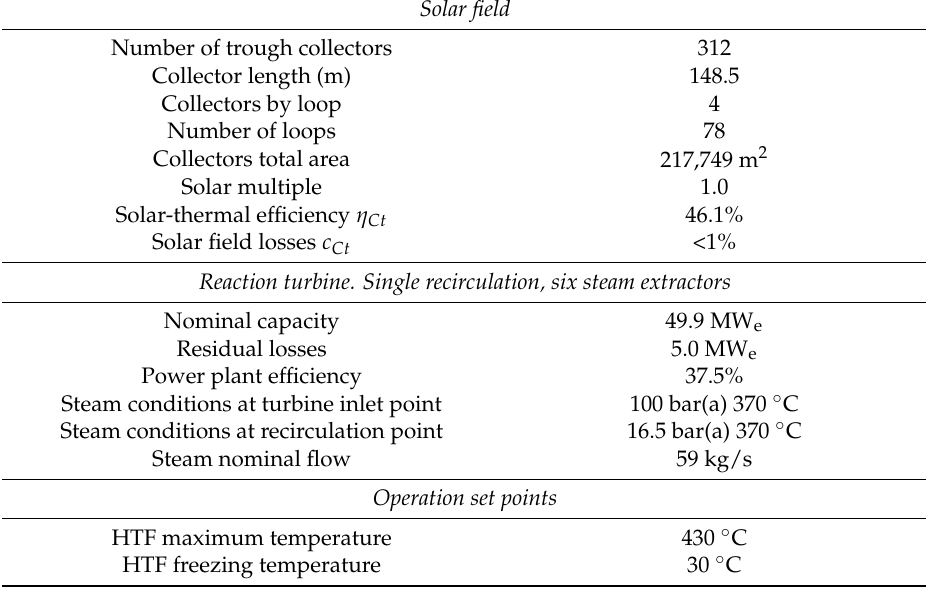
Table 2. Capacity and sizing reference values for a 50-MW e parabolic trough (PT) solar thermal power